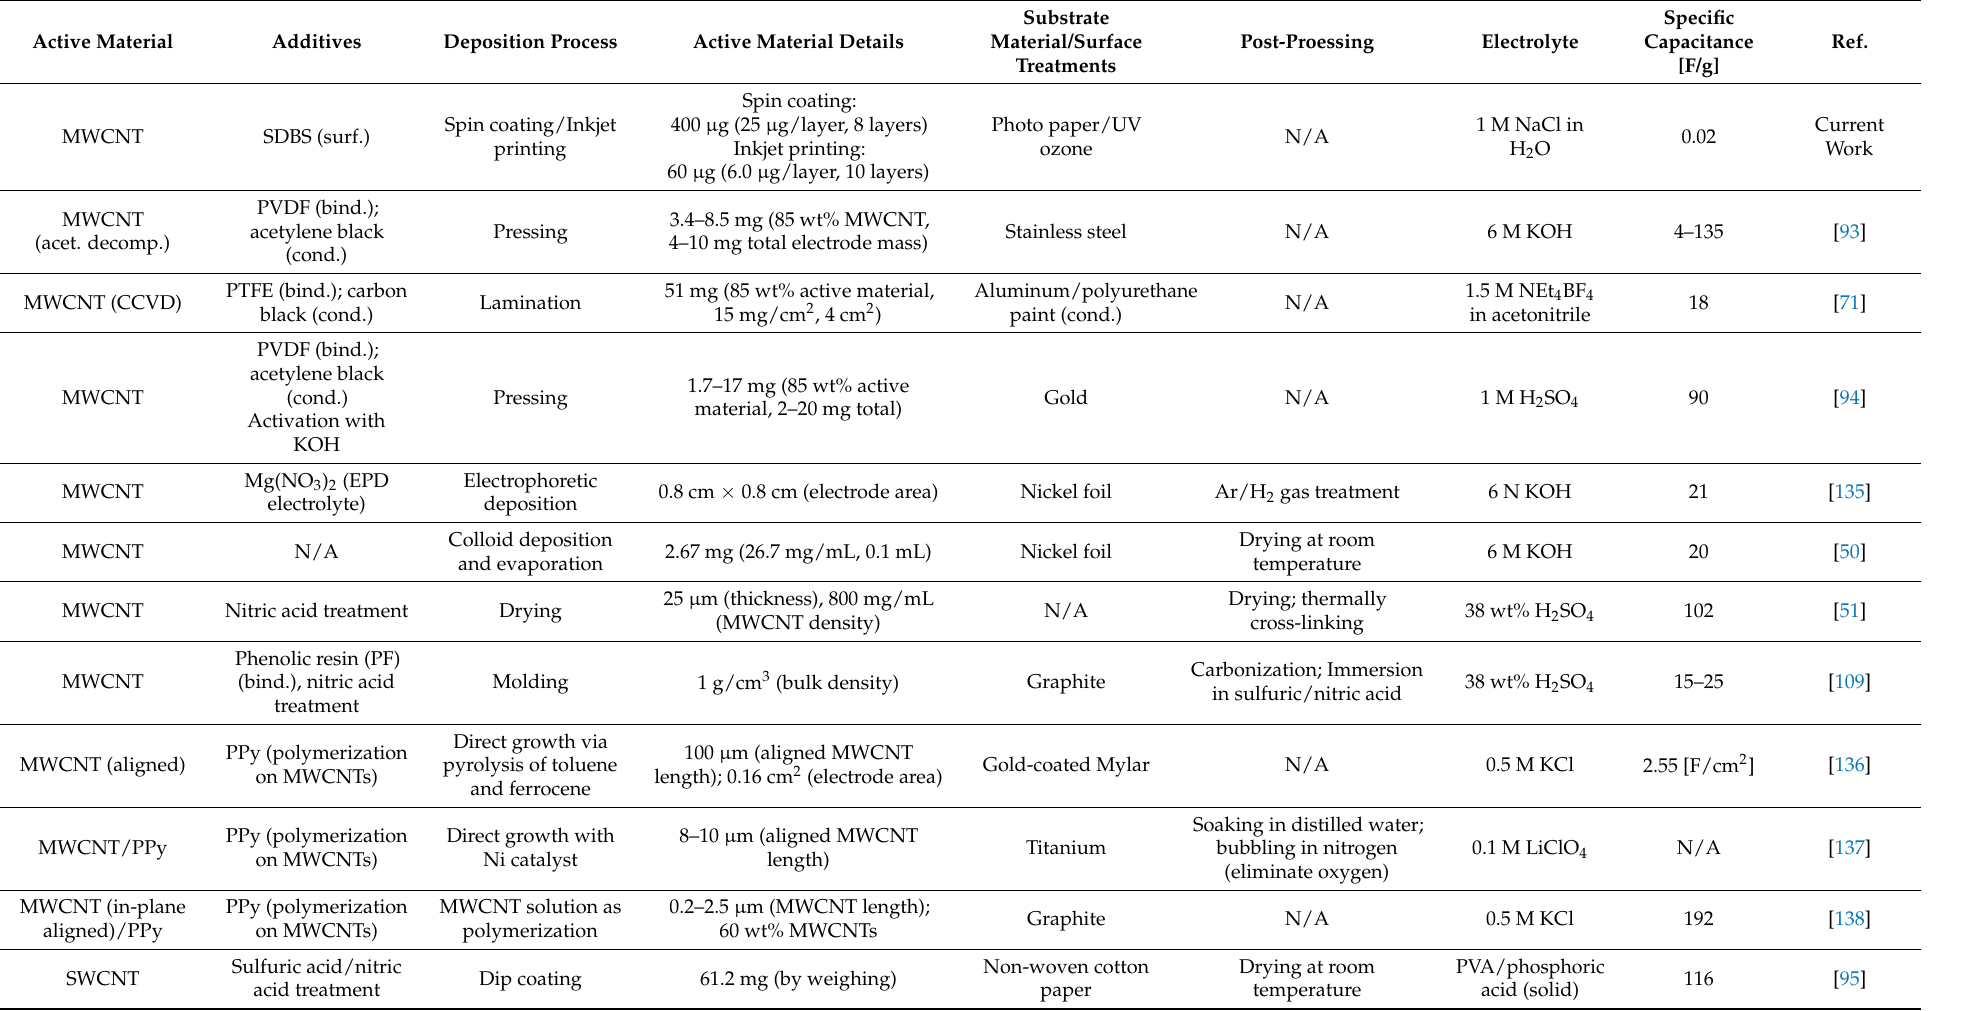
Table 2. Summary of previous investigations of carbon material-based electric double-layer